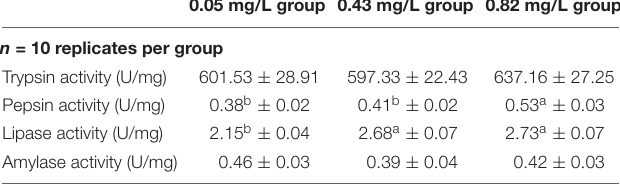
TABLE 4 | Digestive enzyme activity in hepatopancreas of Chinese mitten crab ( Eriocheir sinensis ) fed dietary supplementation with cultured Potamogeton maackianus powder.